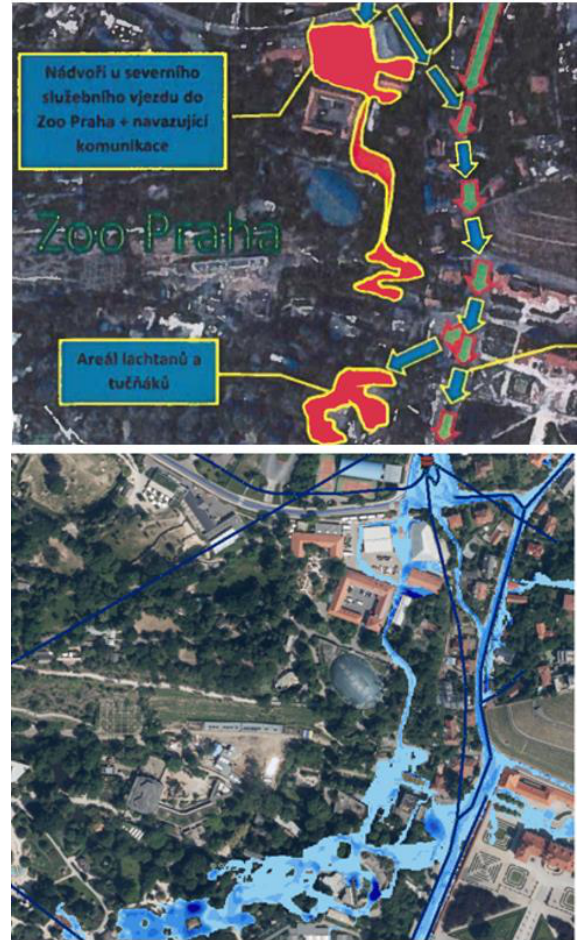
Figure 9. Verification of flood extent (bottom) based on recorded data (top)